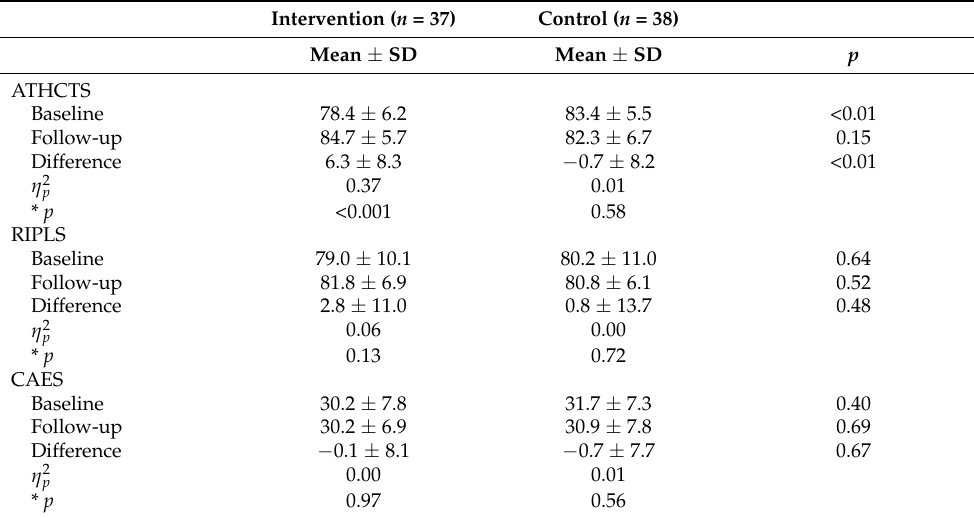
Table 2. Mean difference of ATHCTS, RIPLS, and CAES scores between intervention and con- trol